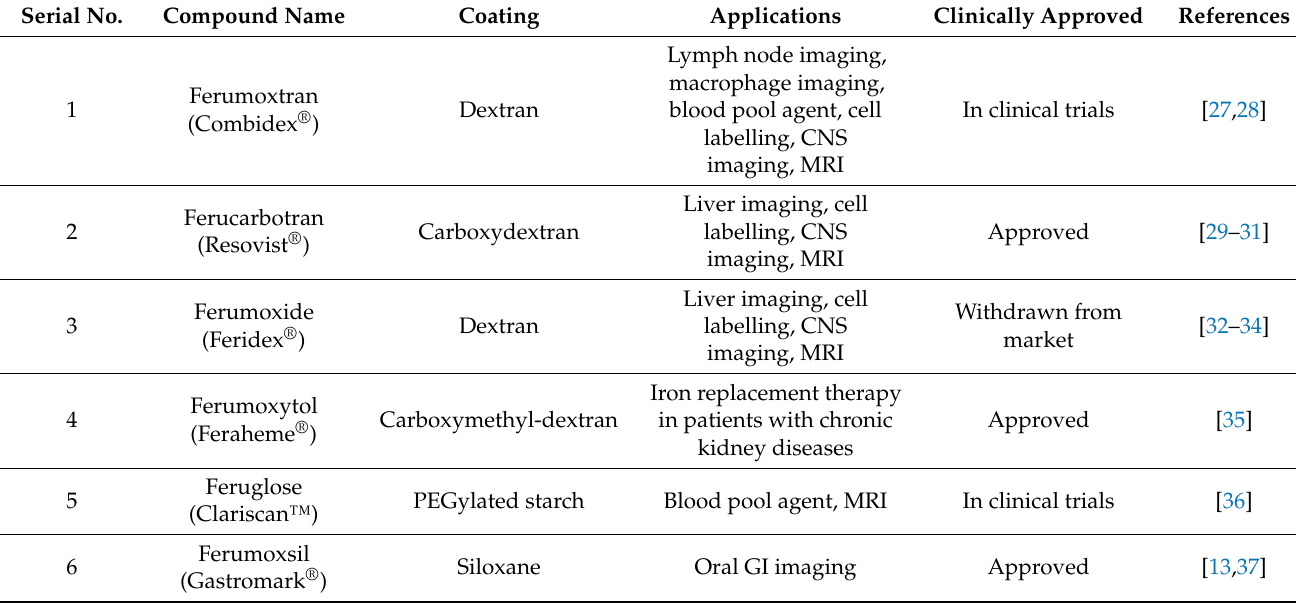
Table 1. Clinically approved IONPs conjugated compounds and its applications at various biomedical platform. Serial